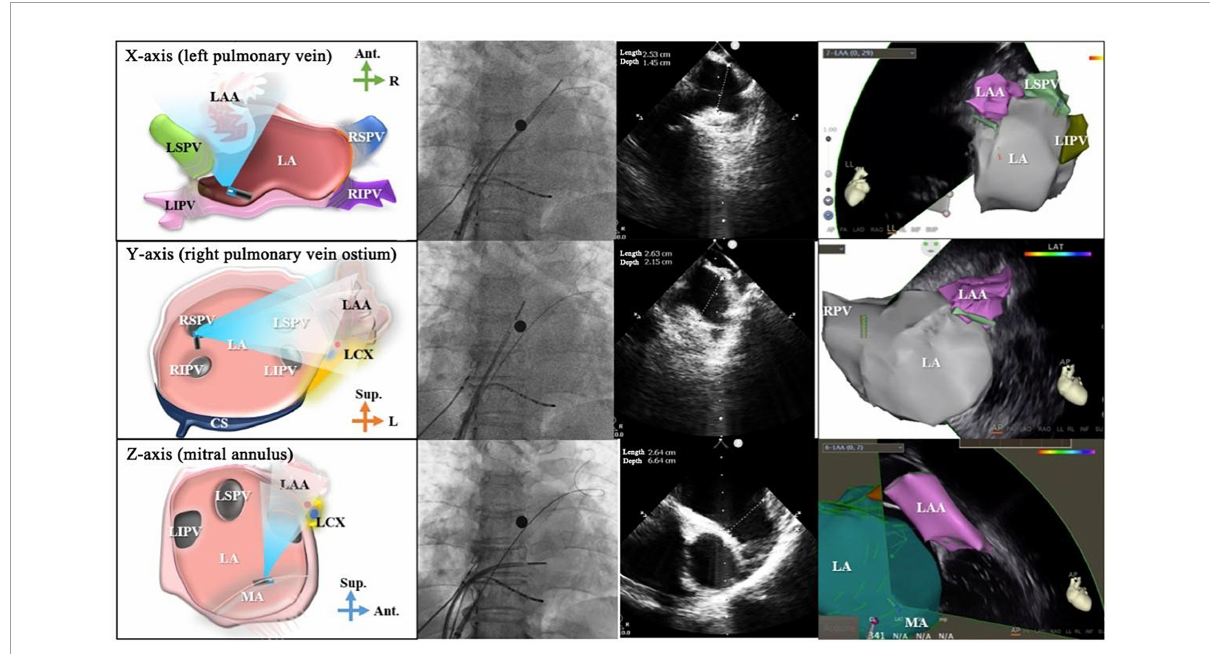
FIGURE10 Multi-angle left atrial appendage measurement. From the top to bottom: schematic diagrams for atrial appendage assessment, X-ray images, ultrasound images and 3D electroanatomical diagrams from X axis, Y axis, and Z axis. The projection position of the X-ray is AP. The first column shows the schematic diagrams, the second column shows the effect of X-ray, the third column shows the images of ICE, and the fourth column shows the images of 3D mapping system. LAA, left atrial appendage; LSPV, left superior pulmonary vein; LIPV, left inferior pulmonary vein; LA, left atrium; RSPV, right superior pulmonary vein; RIPV, right inferior pulmonary vein; LCX, left circumflex artery; Ant., anterior; Sup., superior; R, right; L, left; MA, mitral annulus; RPV, right pulmonary